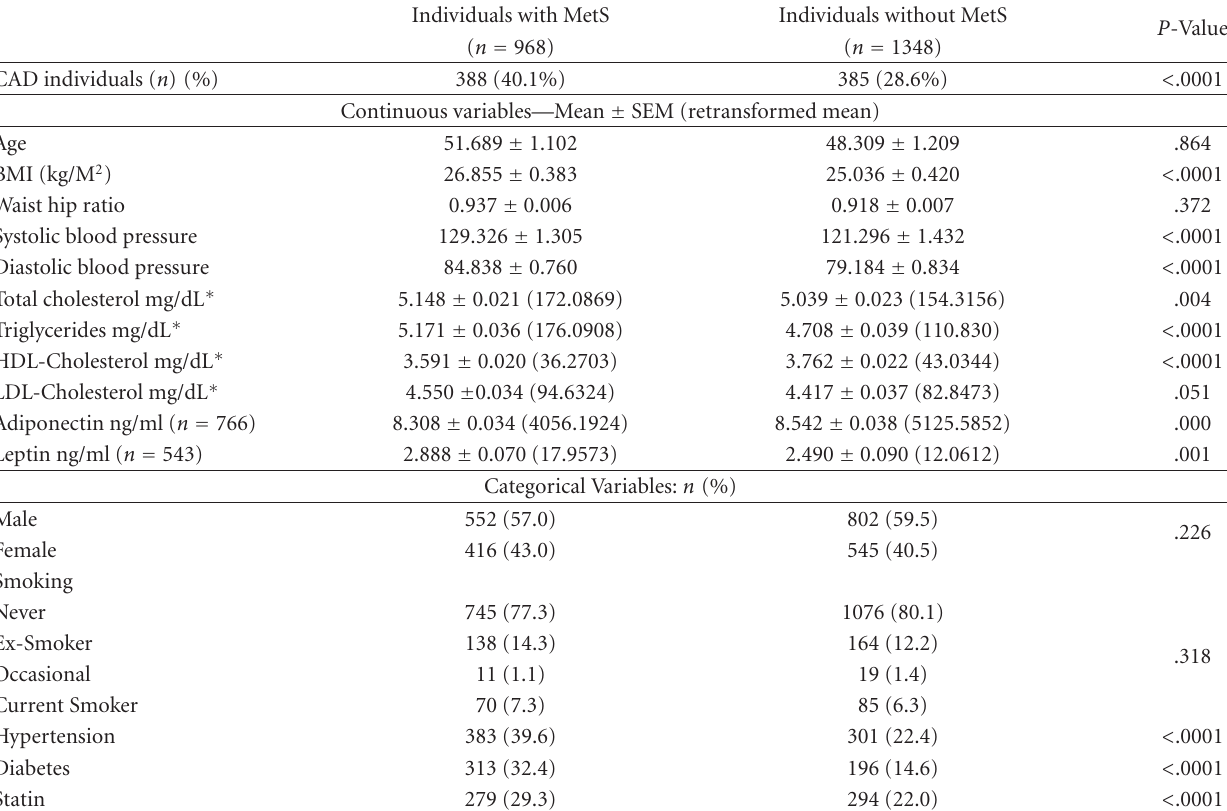
Table 2: Clinical and demographic characteristics of the study subjects. Individuals with MetS